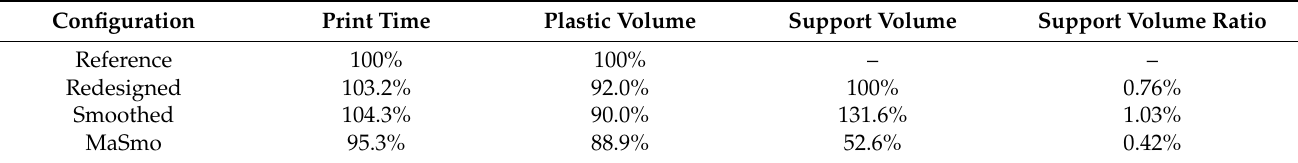
Table 4. Manufacturing data overview. The plastic volume is the actual volume used in production and is referenced on the reference plastic volume. The support volume of redesigned is used as a reference for the comparison of the needed support volume. The support volume ratio is defined by the ratio of the used support structures to the plastic volume. Configuration